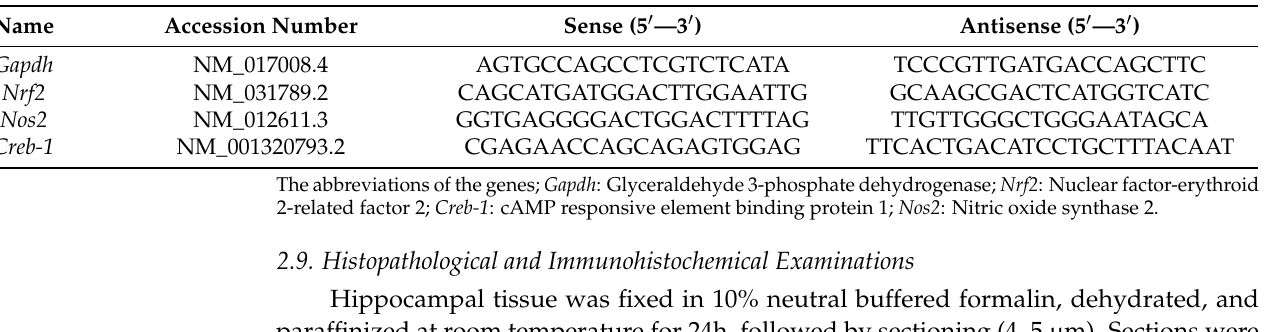
Table 1. Primer sequences of genes analyzed in Real